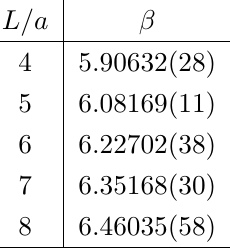
Table 14 . Couplings corresponding to g 2 = 3 : 467 in the SU(3) theory, as a function of L=a .